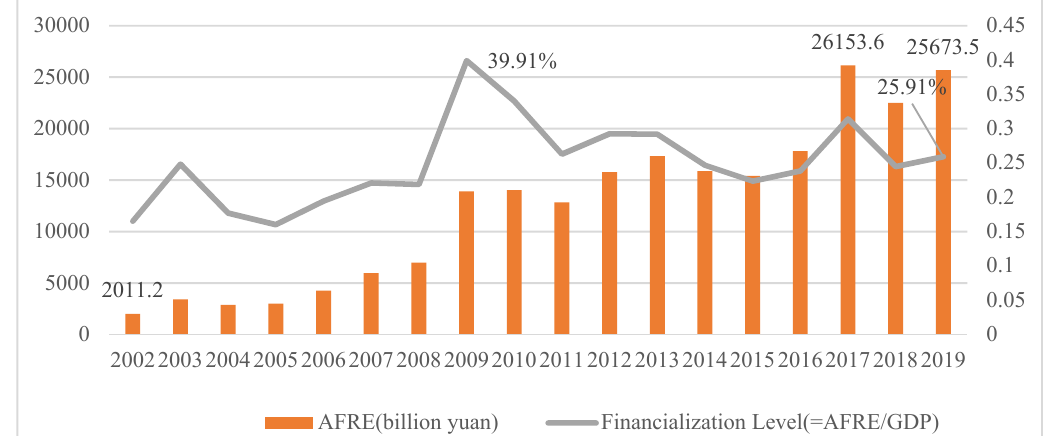
Figure 3. AFRE and financialization level (=AFRE/GDP) in China from 2002 to 2019. Source: China’s National Statistical Bureau.